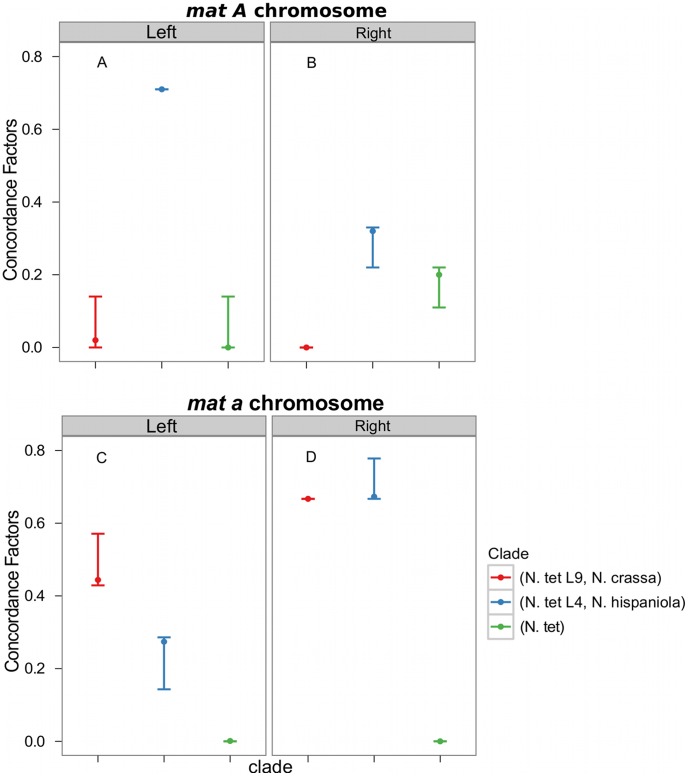
Concordance factors on the mating-type (mat) chromosome support a post-introgression crossover between the Neurospora tetrasperma L4 mat chromosomes.The concordance factors are plotted to the left and right of the crossover event described by Menkis et al. (2010) for both the mat A (A and B) and mat a (C and D) chromosomes. Concordance factors are given for the three hypotheses illustrated as clades in the plot, red: N. tetrasperma L9 sister species to N. crassa; blue: N. tetrasperma L4 sister species to N. hispaniola; green: N. tetrasperma monophyletic. The results displayed were calculated with the prior alpha set to 1.